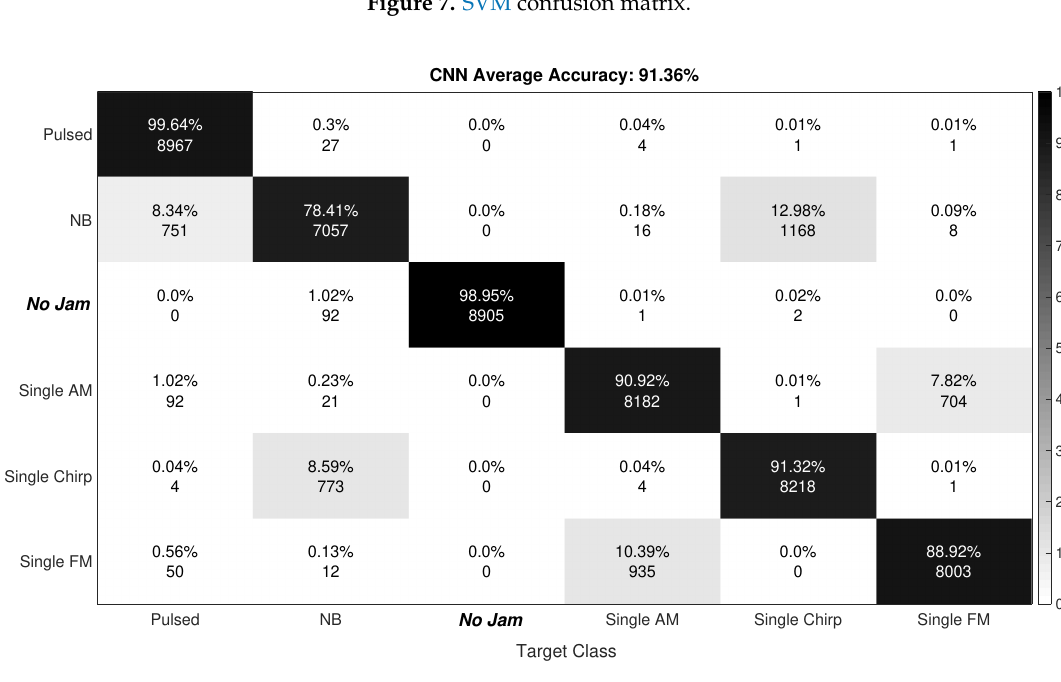
Figure 8. CNN confusion